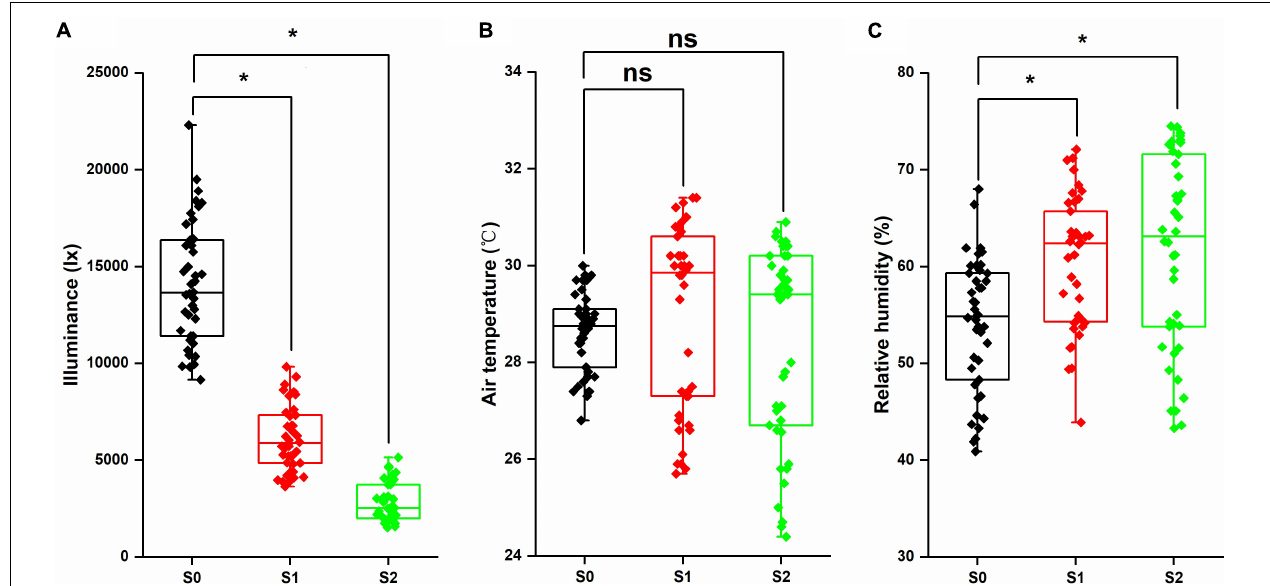
FIGURE 1 | Illuminance (A) , air temperature (B) , and relative humidity (C) in the mung bean field under shading stress. *Significant at 0.05; ns, no significant difference. S0, no shading; S1, moderate shading; and S2, severe shading.